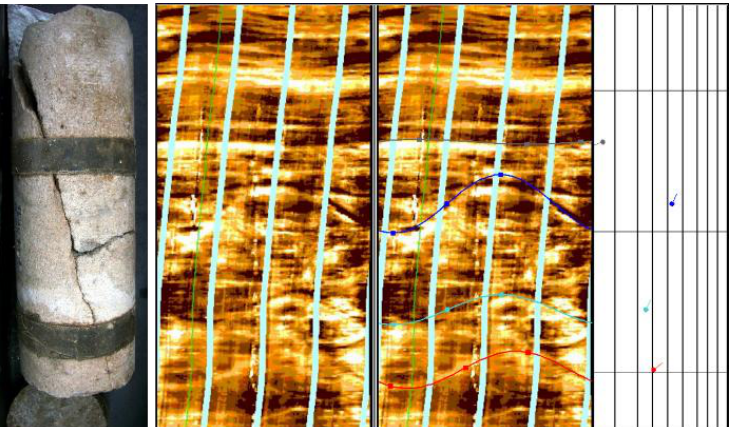
Figure 3—Fracture interpreted from FMI in comparing with the fractures observed on core of well A.